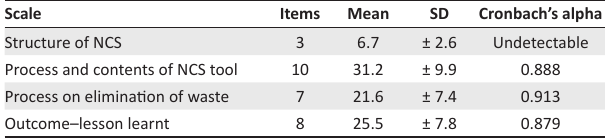
TABLE 6: Descriptive statistics and Cronbach’s alpha. TABLE 5: Perceptions of nurses regarding outcome standards of the National